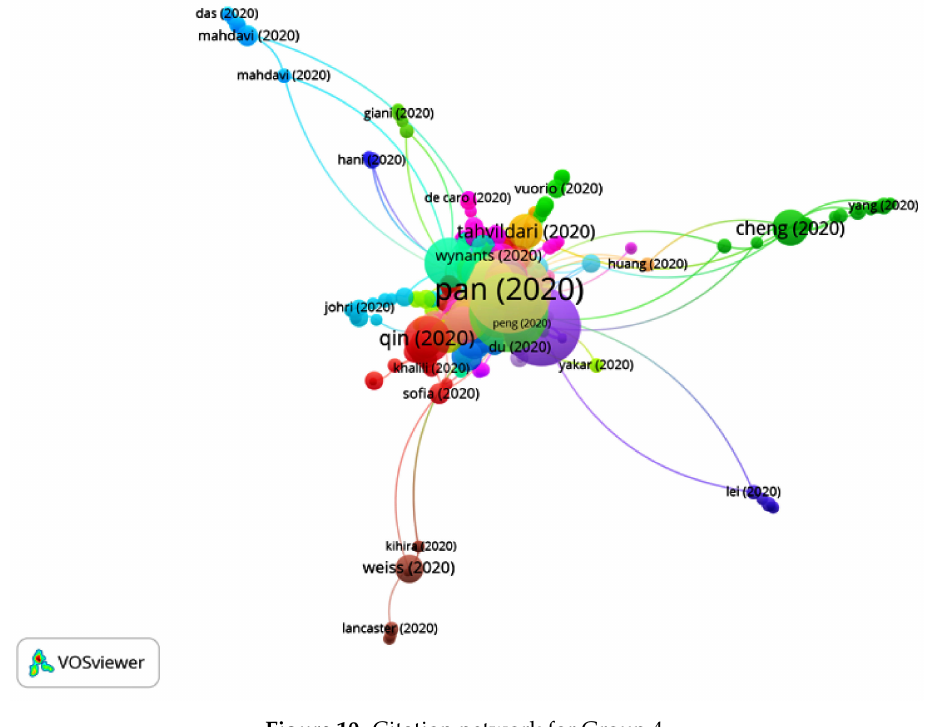
Figure 10. Citation network for Group 4.